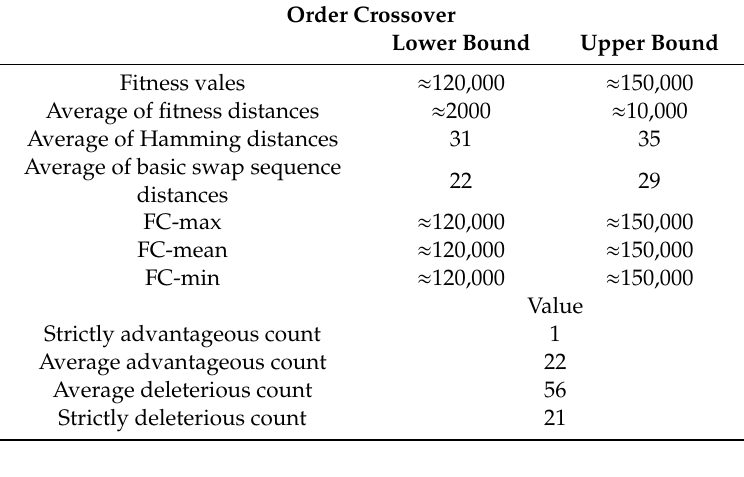
Table 7. Order crossover distances results.